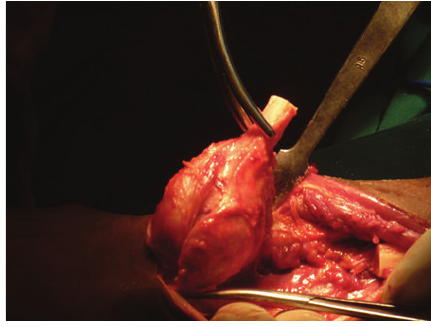
Figure 7: Distal ulna resected.